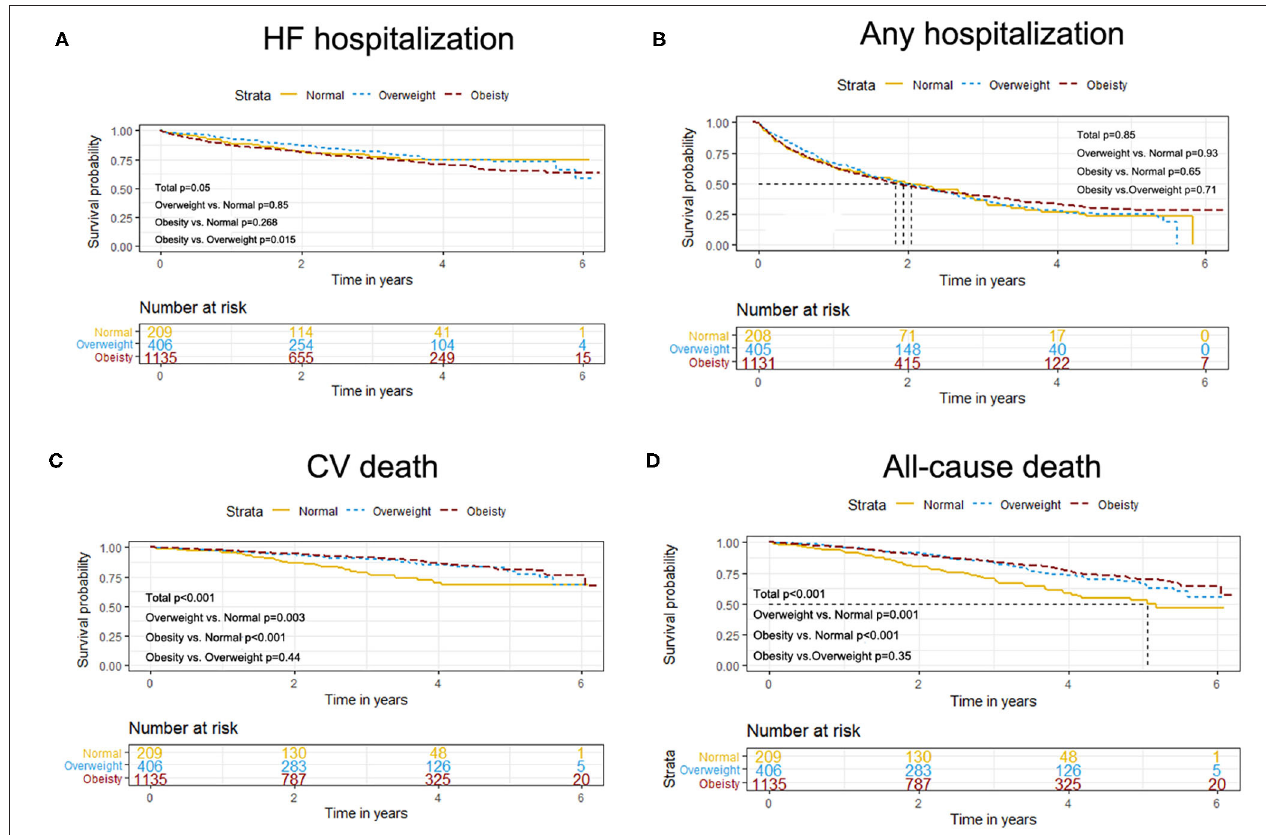
FIGURE 2 | K–M survival curves for cardiovascular death (A) , all-cause death (B) , HF hospitalization (B) , and any hospitalization (D) based on the predefined BMI categories in HFpEF. HFpEF, heart failure with preserved ejection fraction; HF, heart failure. lower risks of cardiovascular death (HR = 0.51, 95% CI: 0.27– 0.95) and all-cause death (HR = 0.54, 95% CI: 0.33–0.86) compared with normal weight. Obesity was associated with a decreased risk of all-cause death (HR = 0.64, 95% CI: 0.43–0.98)